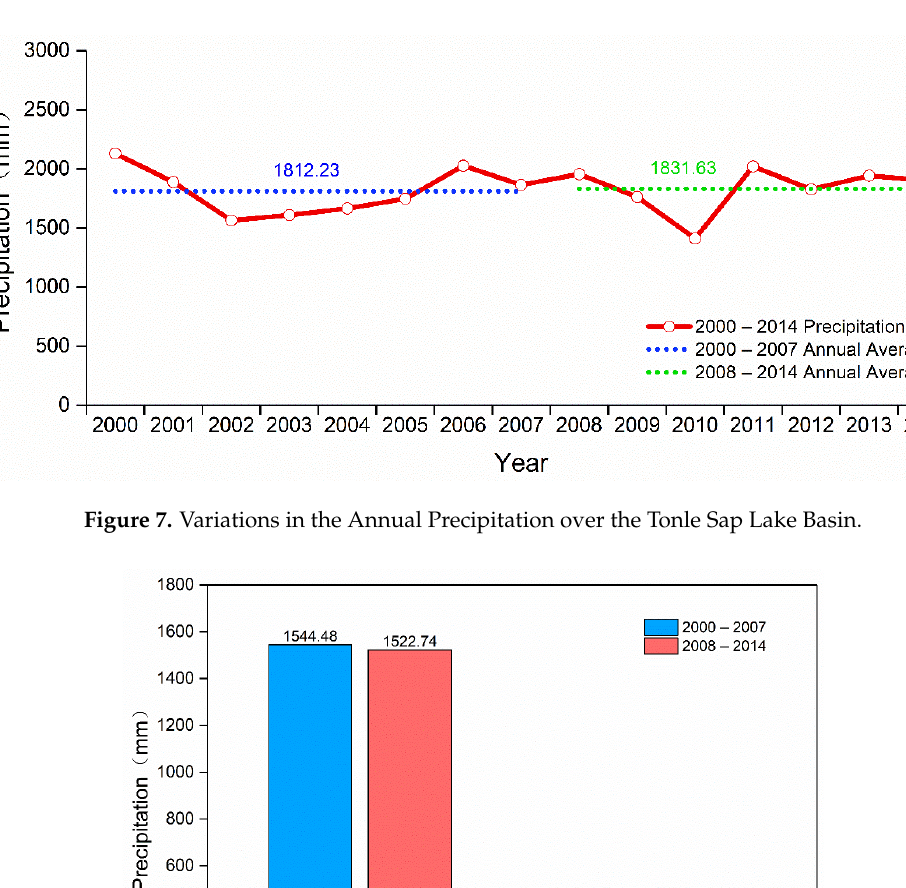
Figure 7. Variations in the Annual Precipitation over the Tonle Sap Lake Basin.